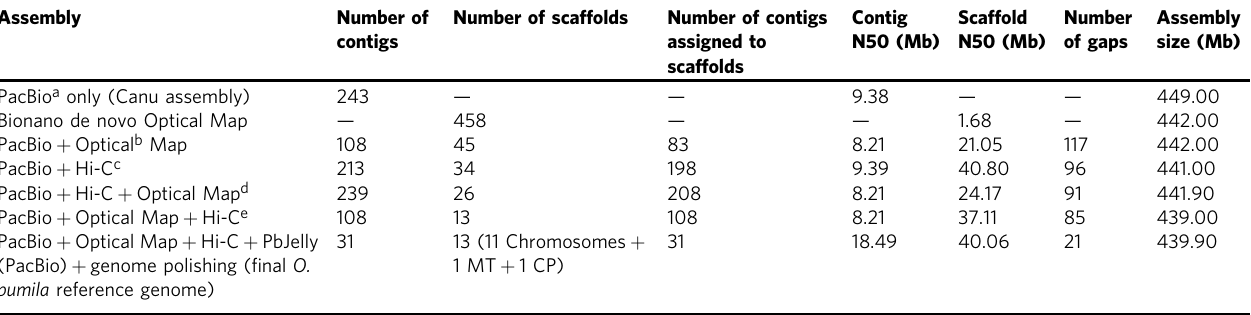
Table 1 O. pumila reference genome assembly statistics at different stages and combinations of scaffolding.